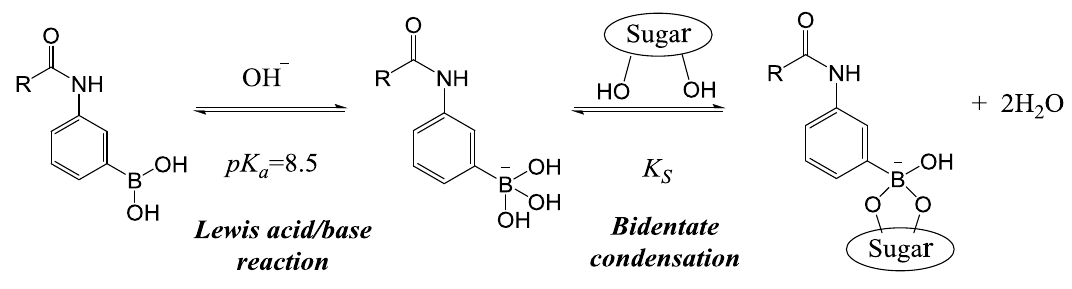
Figure 1. Complex between phenylboronic acid (PBA) moiety and a sugar molecule in aqueous solution [8,25,26].